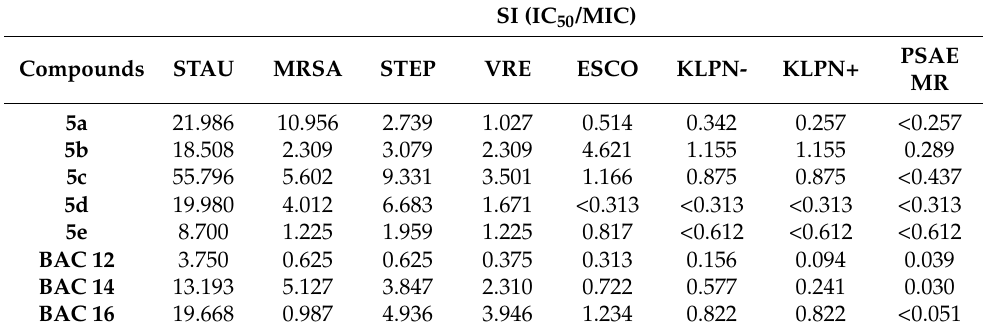
Table 6. The selectivity indexes of benzoxonium-like salts calculated as ration IC 50 /MIC (24h).